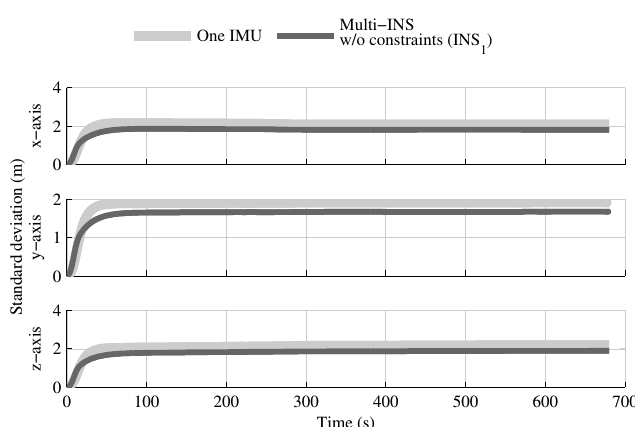
Figure 7. The position estimation error standard deviation obtained with the first INS of the multi-INS fusion without constraints versus the one obtained with the single IMU solution.